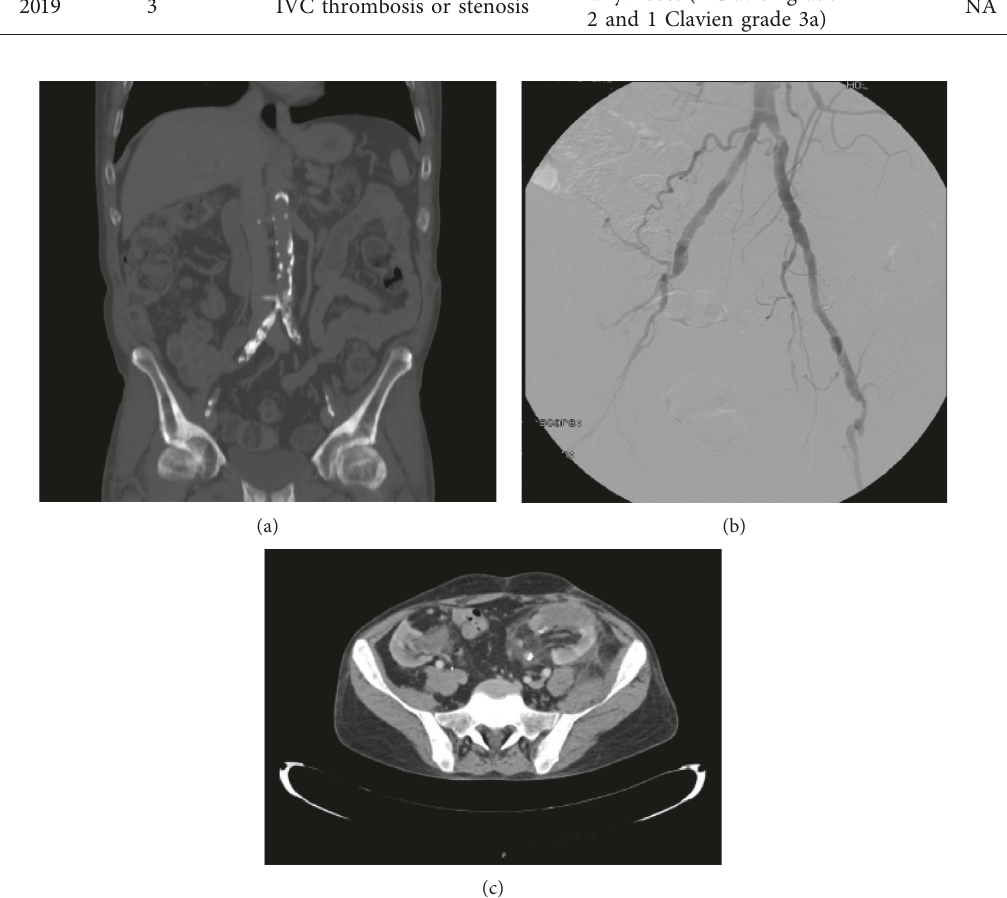
Figure 4: (a). Important aortoiliac calcification. (b). Arteriography showing left external iliac artery stenosis. (c). Bilateral occupation of the iliac fossae by prior kidney